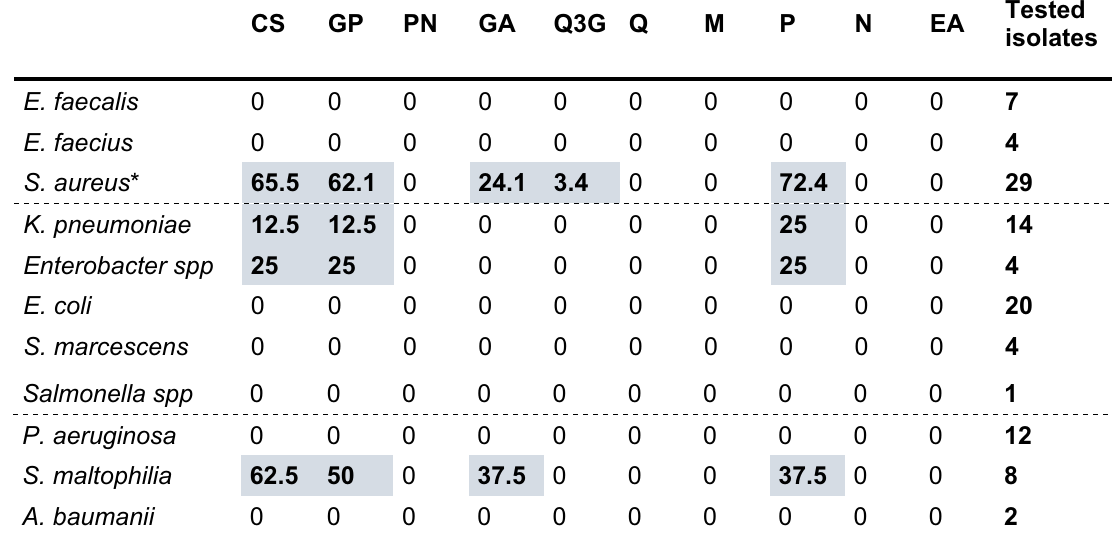
Table 1. Percentage of sensitive isolates of gram-positive cocci (rows 1–3), Enterobacteria (rows 4–8) and nonfermentative Gram-negative bacilli (rows 9–11) species to each extract or pure compound. The dotted lines separate the different groups of bacteria. * S. aureus includes both MRSA and MSSA isolates indistinctly.